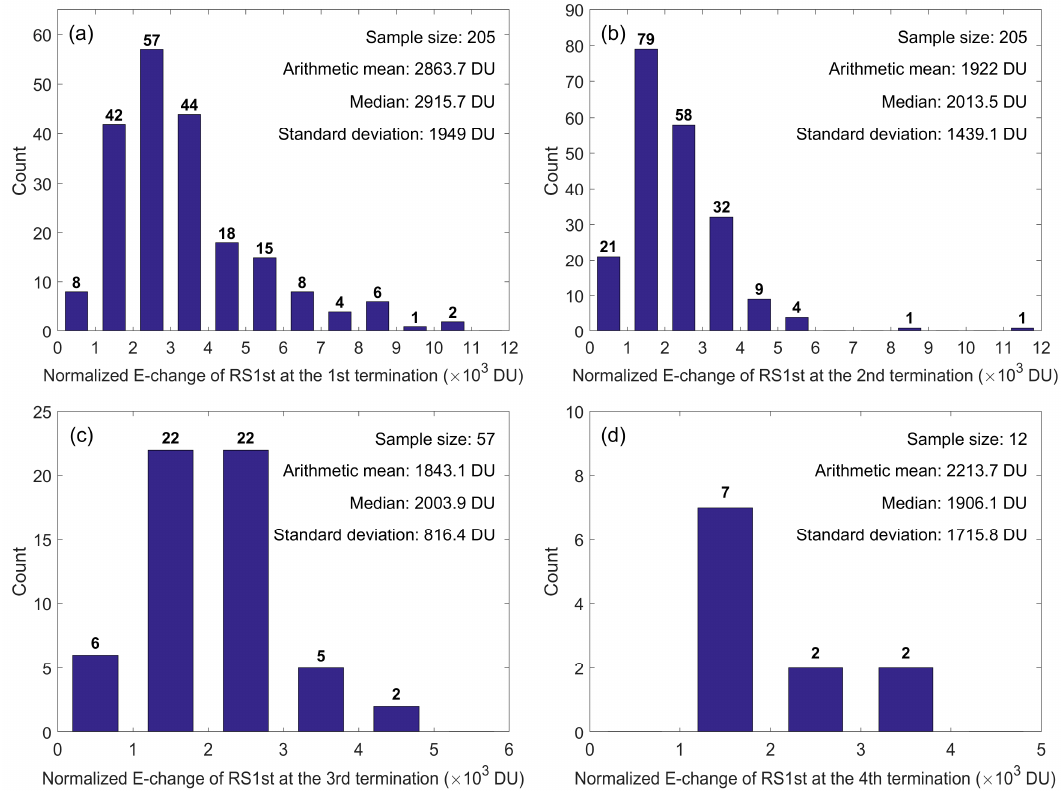
Figure 9. Histogram of the RS 1st intensity at each type of termination separated by termination occurrence orders ( a ) for the first terminations, ( b ) second terminations, ( c ) third terminations, and ( d ) fourth terminations.